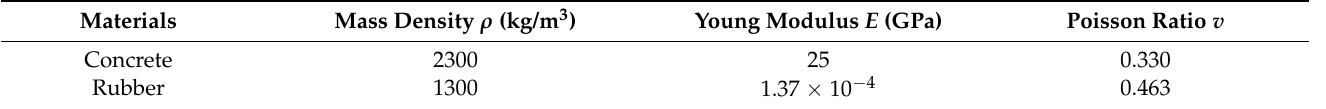
Table 1. Material